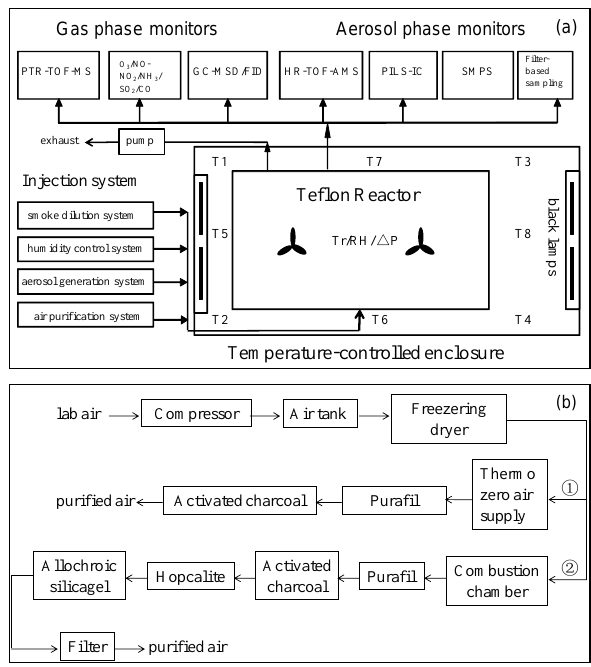
Fig. 1. (a) Schematic of the GIG-CAS smog chamber facility. T1-T8 are thermocouples in the enclosure and T r is temperature sensor inside the reactor. (b) Schematic of two air purification systems. Route 1 represents the procedures of the Thermo zero air supply system; Route 2 represents the procedures of the larger flow rate air purification system.